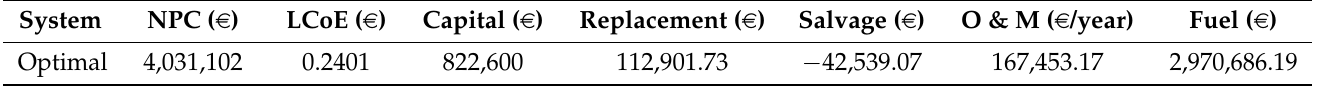
Table 20. Economic characteristics of the optimal configuration of Scenario